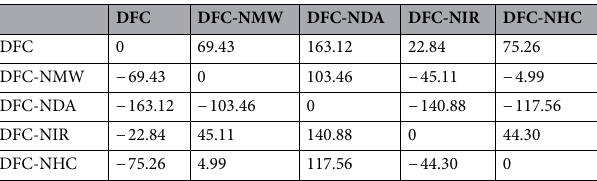
Table 4. McNemars test results for SanFrancisco dataset achieved by using 750 training samples per